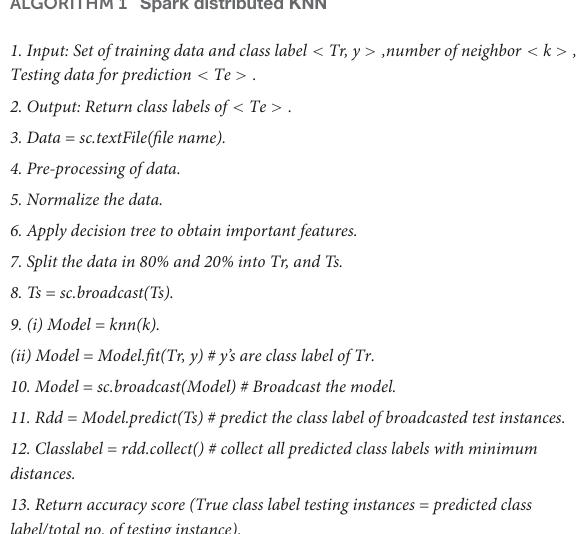
Two algorithms are presented below.